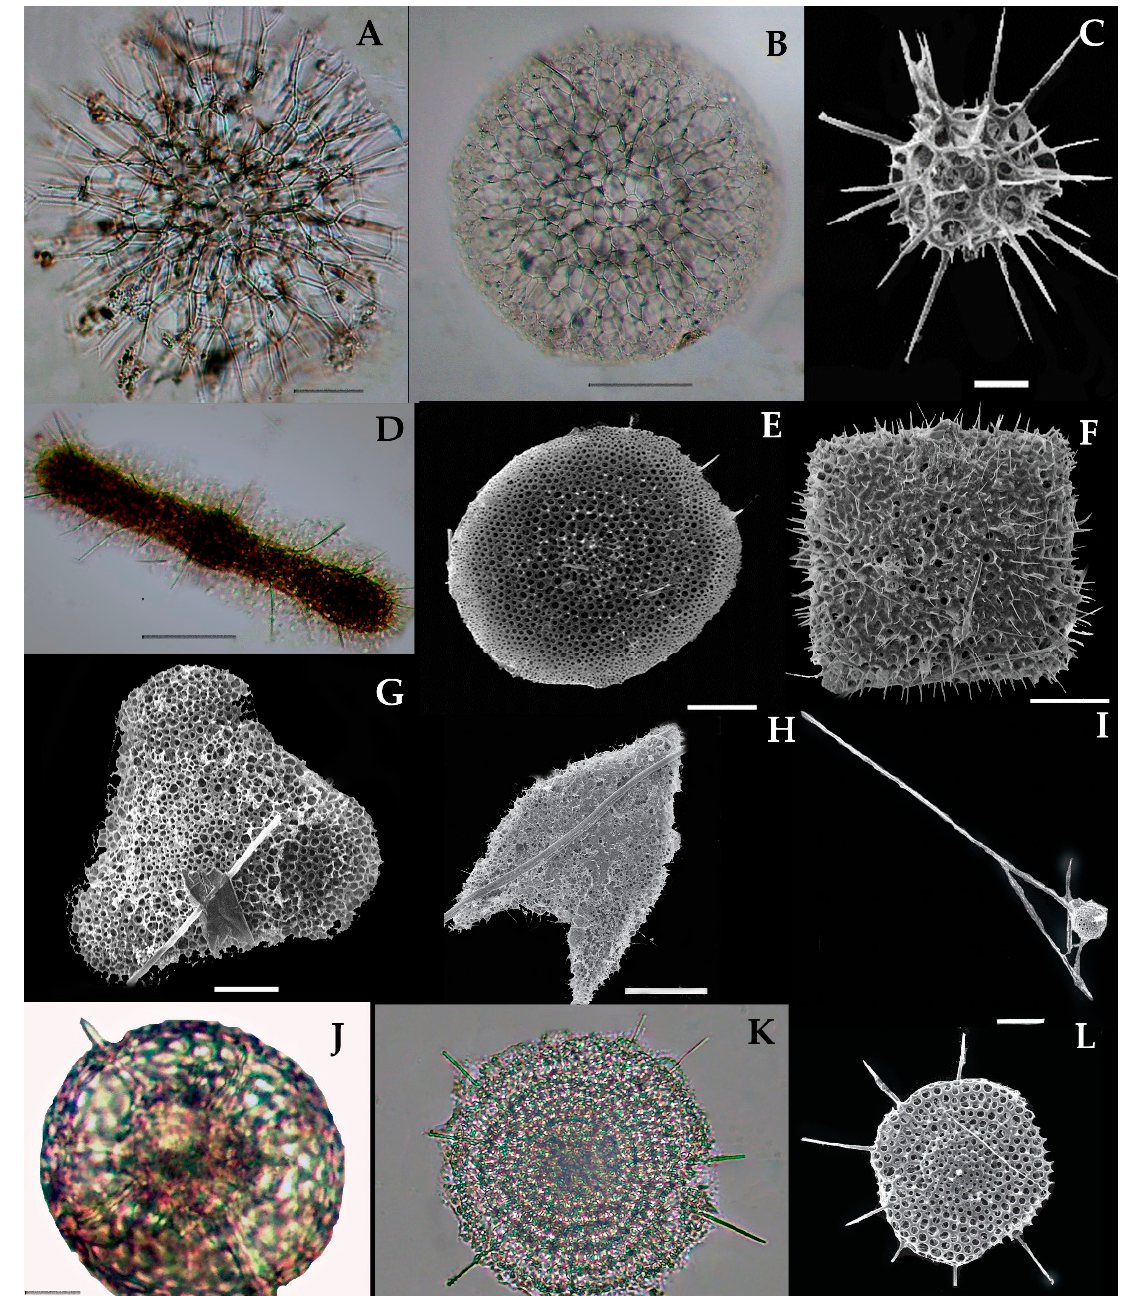
Figure 7. Photomicrographs of Spumellarian species in the eastern Indian Ocean. Images were modified from Munir et al. [27]. ( A ) Styptosphaera spongiacea , ( B ) Spongodictyon spongiosum , ( C ) Streblacantha circumtexta, ( D ) Spongurus cylindricus , ( E ) Spongurus pylomaticus, ( F ) Spongaster tetras tetras, ( G ) Spongodiscus sp., ( H ) Euchitonia elegans, ( I ) Xiphosphaera tessaractis, ( J ) Xiphatractus sp. , ( K ) Stylodictya multispina, ( L ) Stylochlamydium venustum. Scale bars: 10 µm, 20 µm, 100 µm.